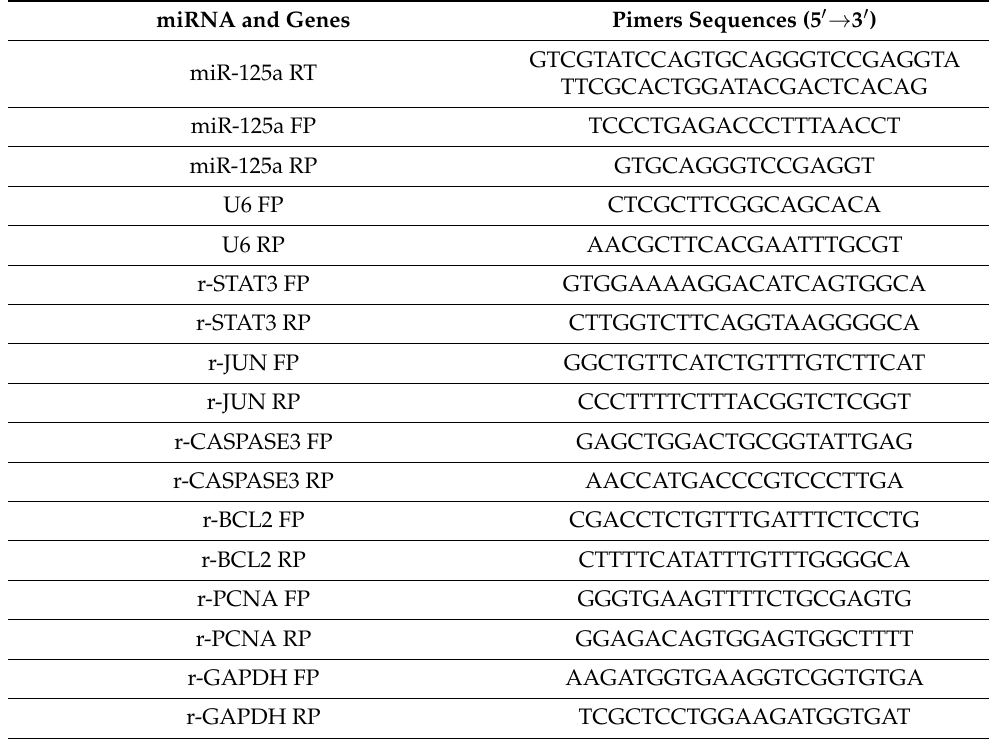
Table 3. Primers used in reverse transcription and quantitative real-time